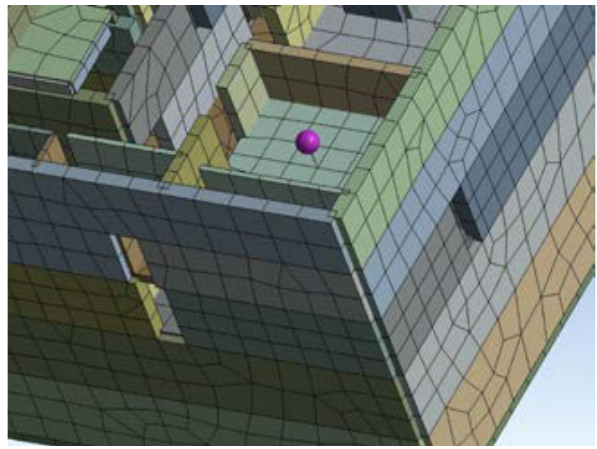
Figure 9. SDOF oscillator located at equipment location 3 for validation of two-DOF analysis. The mass of the SDOF oscillator corresponded to 1% of the entire building